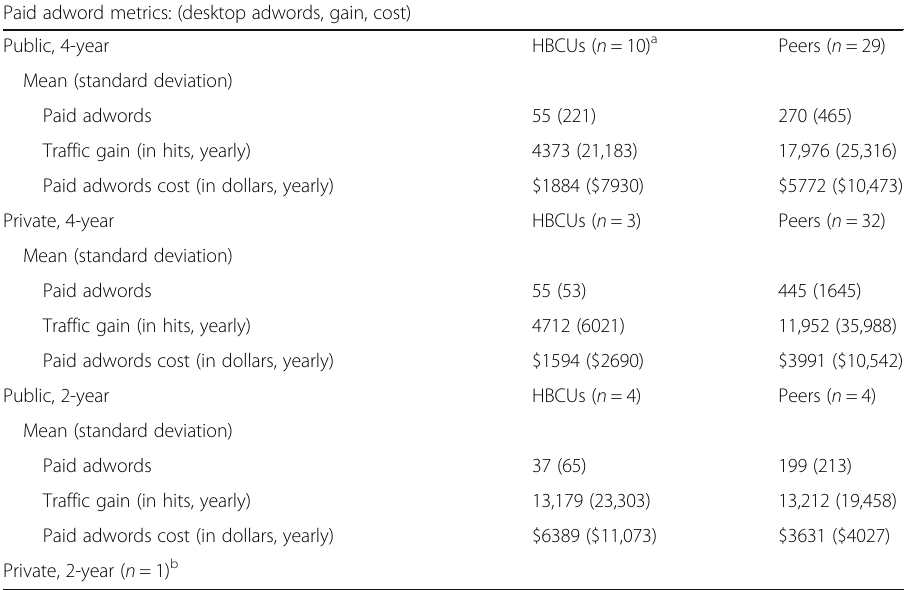
Table 2 Comparison of HBCUs to comparable institutions by desktop paid adwords, current as